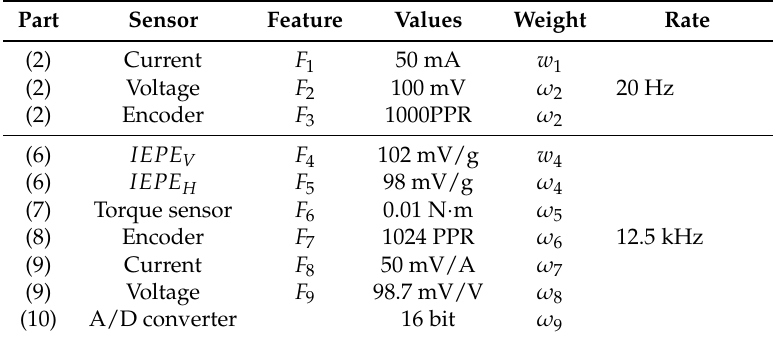
Table 3. Sensor parameter